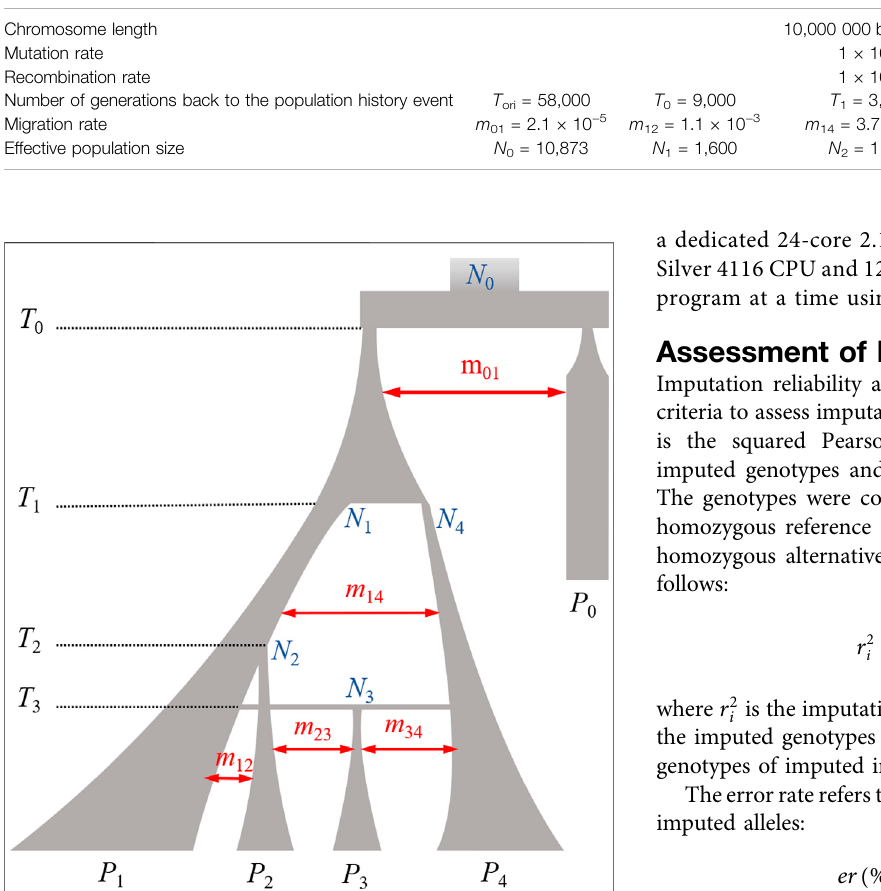
both with default parameter settings. Each program was run using its speci fi c formats for reference panel data (bref3 for Beagle5.1 and m3vcf for Minimac4). We used Minimac3 to